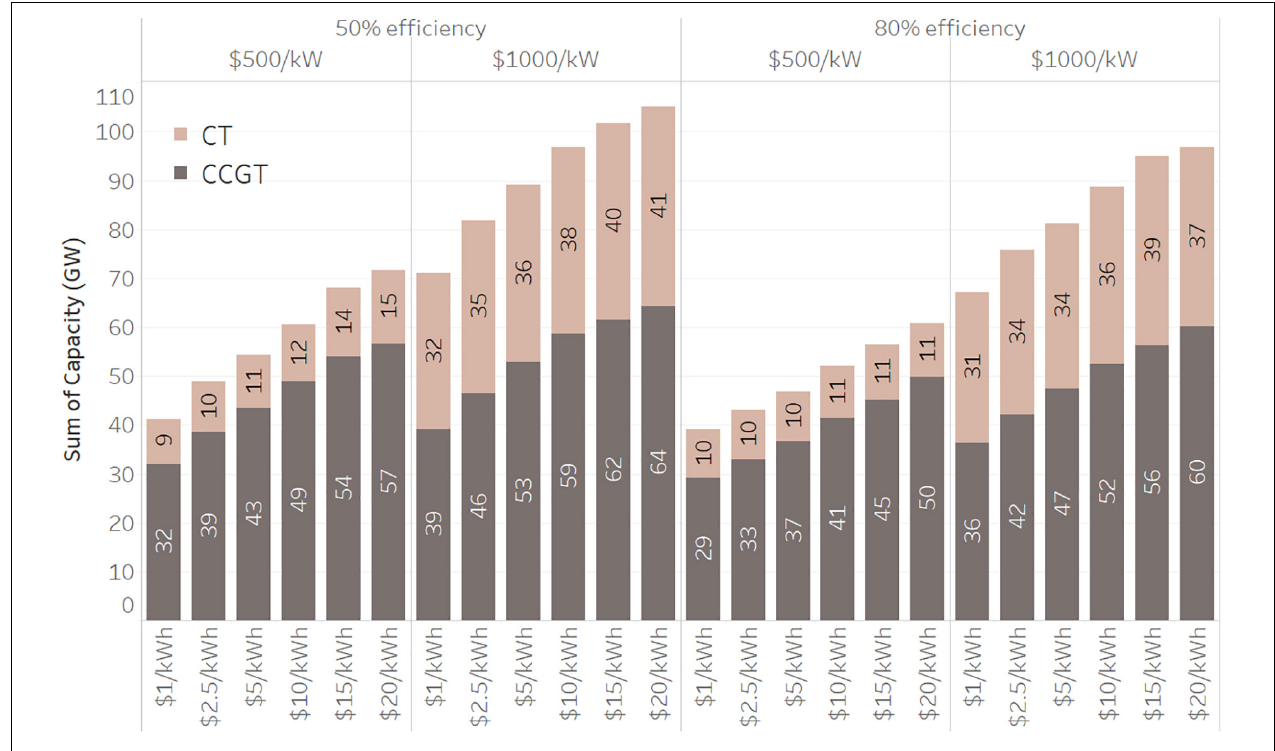
FIGURE 4 | Gas capacity in 2050 at different LTS costs ( top labels: efficiency and $/kW cost, bottom labels: $/kWh cost).